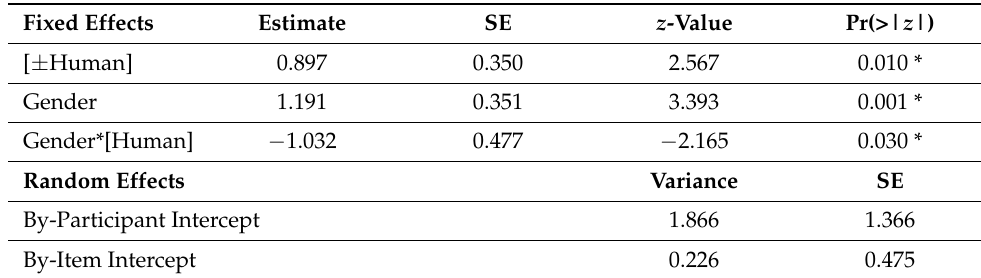
Table 6. Linear mixed-effects model, picture selection task, L2 group.